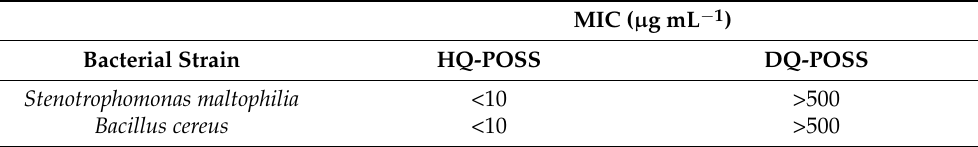
Table 2. MIC of HQ- and DQ-POSS against Gram-positive and -negative marine environmental